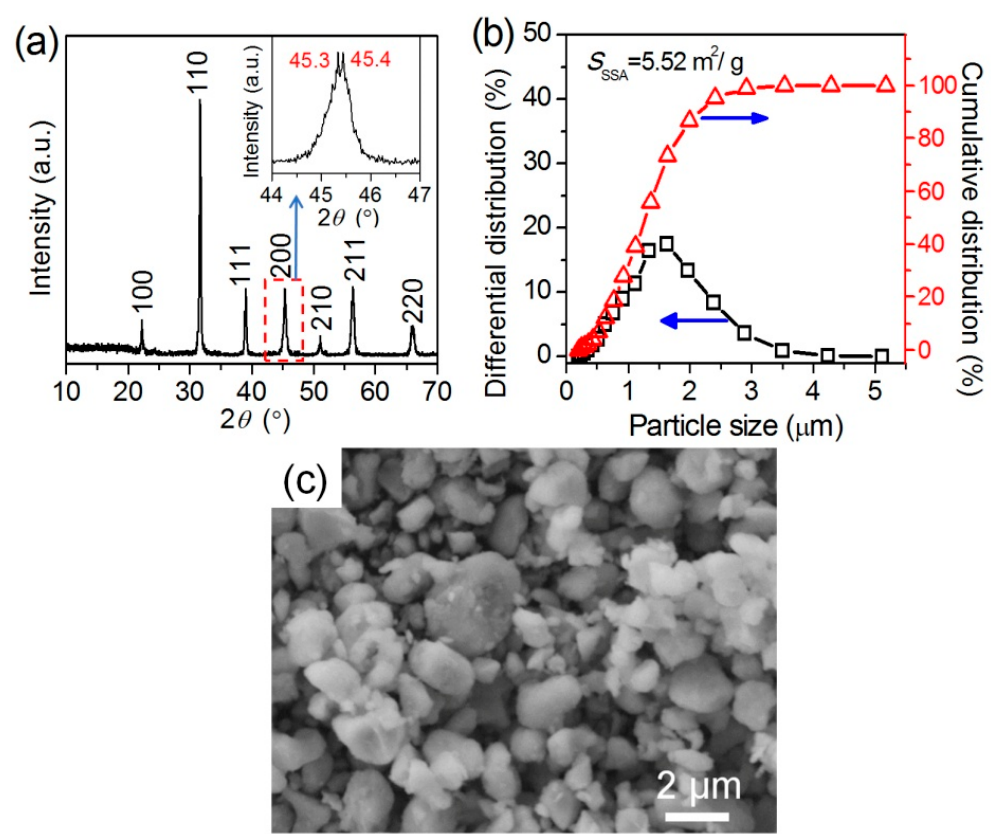
Figure 2. ( a ) X-ray diffraction (XRD) pattern, ( b ) particle-size distributions and ( c ) typical scanning electron microscopy (SEM) image of the pristine BT powders.